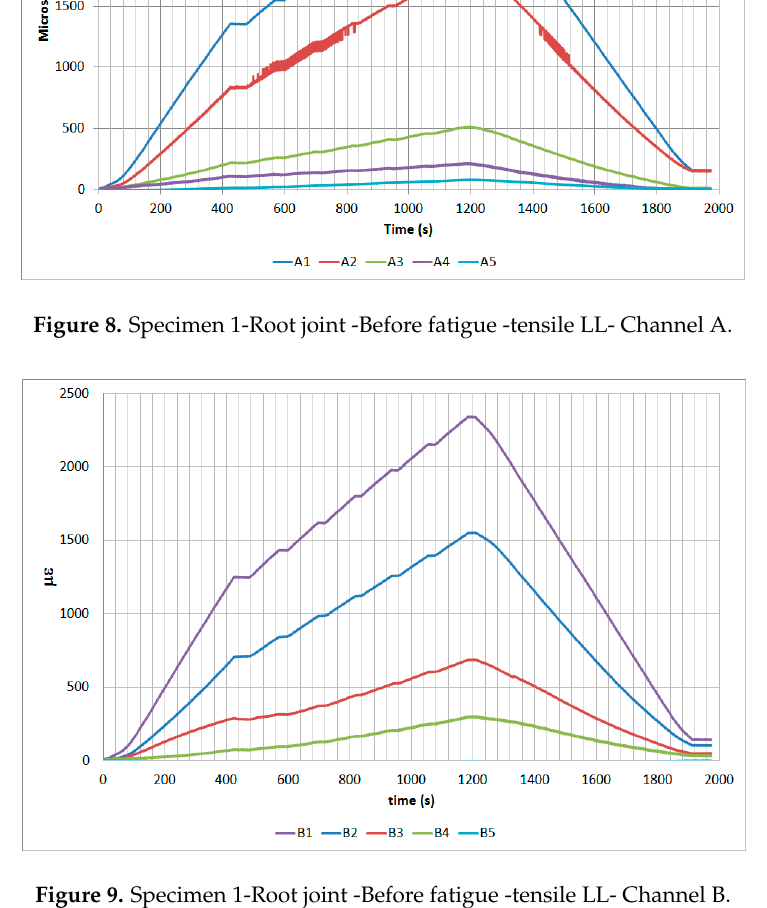
Figure 9. Specimen 1-Root joint -Before fatigue -tensile LL- Channel B.